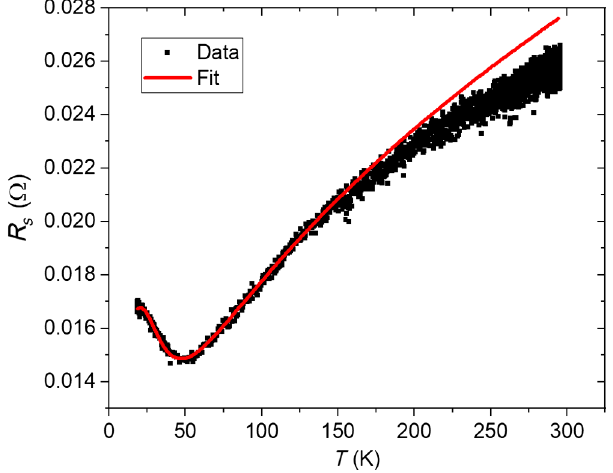
FIG. 17. Picture of the TLA used to connect the cavity to stage 2 of the CCR.